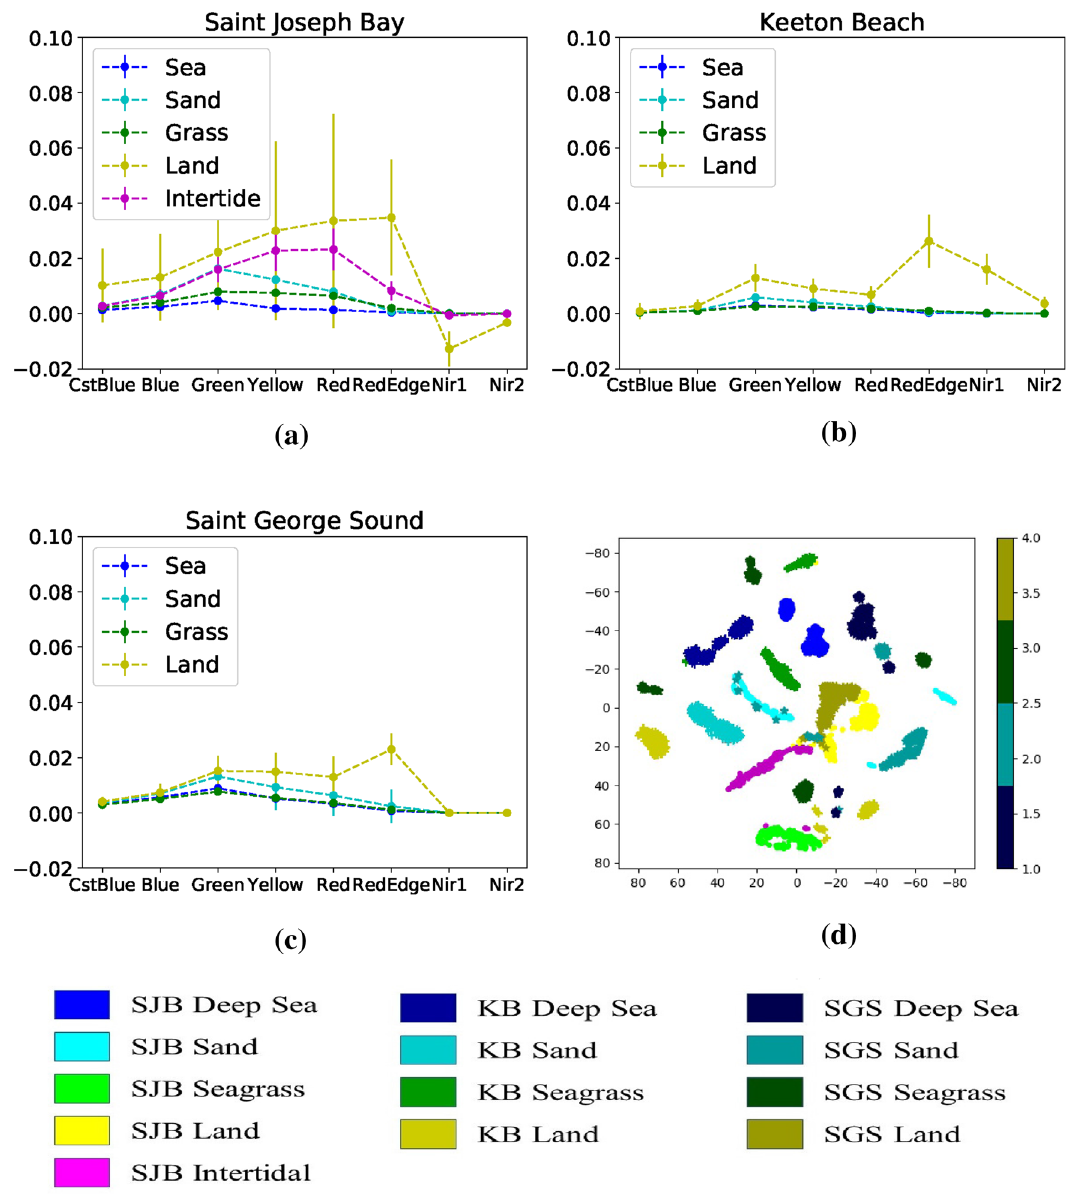
Fig. 4 Atmospherically corrected spectral signature, means and standard deviations in mutlispectral WorldView-2 images for different classes shown at a SJB b KB and c SGS. X-axis represents differ- ent bands, and Y-axis represents spectral intensity mean and standard deviation. d t -SNE plotting of all three locations for different classes. Green, blue, cyan, yellow and magenta are used to represent sea-